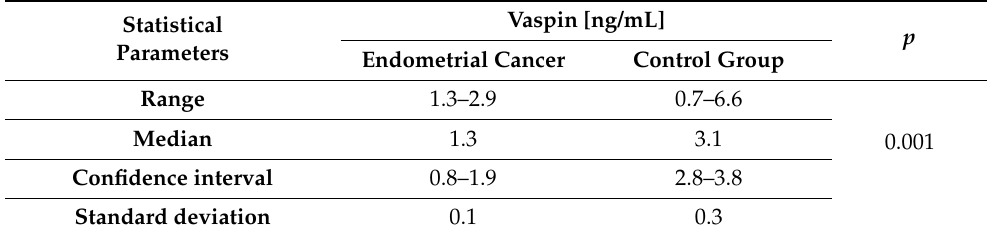
Table 7. Serum vaspin concentrations in patients from the study and control groups.